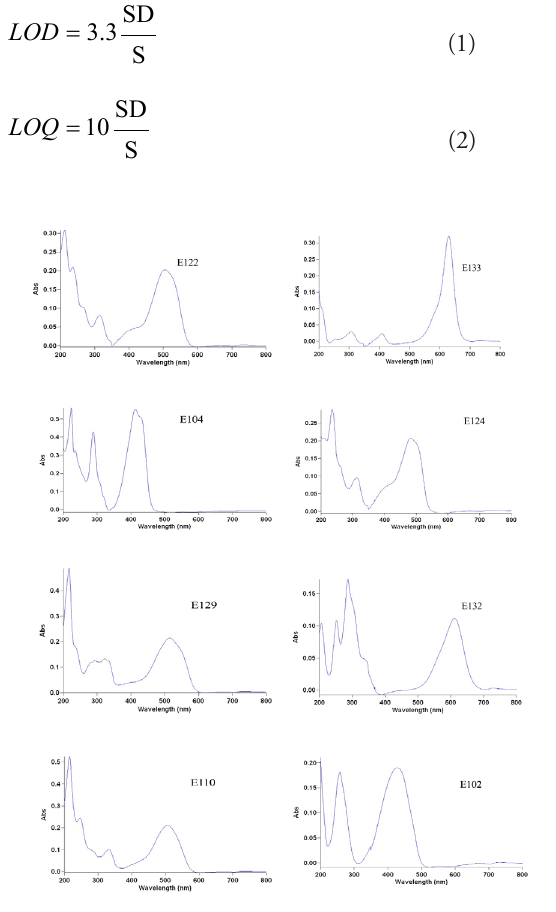
Figure 1. UV-VIS spectra of 8 synthetic food colors collected from individual solution (5 µg/mL).